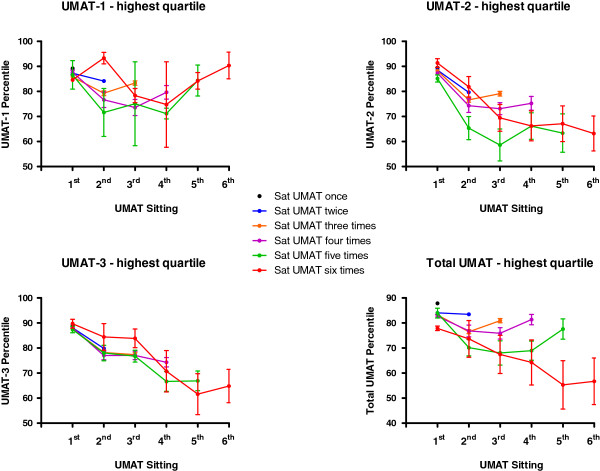
Total UMAT percentile score and percentile score in each of its 3 subsections (± SEM) by number of times candidates re-sat the test between 2000 and 2012 for those in the highest performance quartile in their first test. Error bars are absent where they are too small relative to the mean.